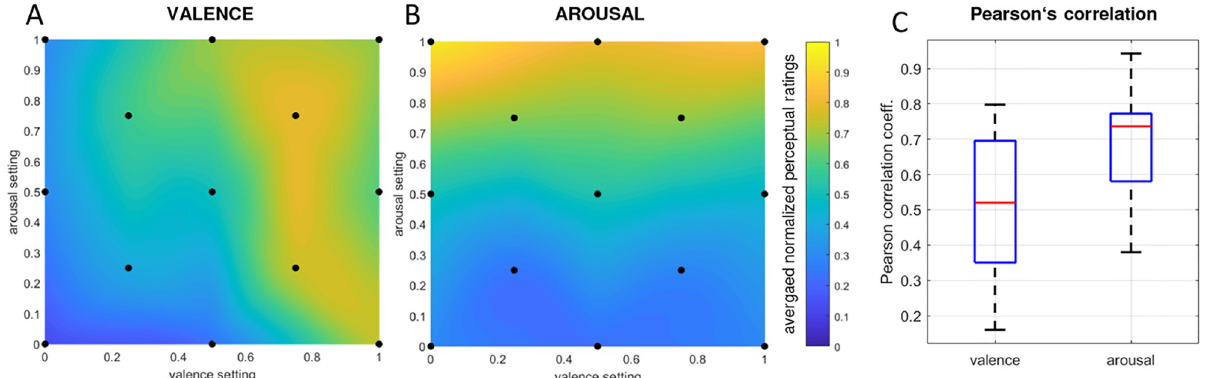
Fig 5. Listening study perceptual ratings. (A) Interpolated valence- and (B) arousal-ratings averaged across subjects. (C) Distribution of per-subject Pearson correlation coefficients between perceptual ratings and the music generation system‘s parameter settings for valence and for arousal.